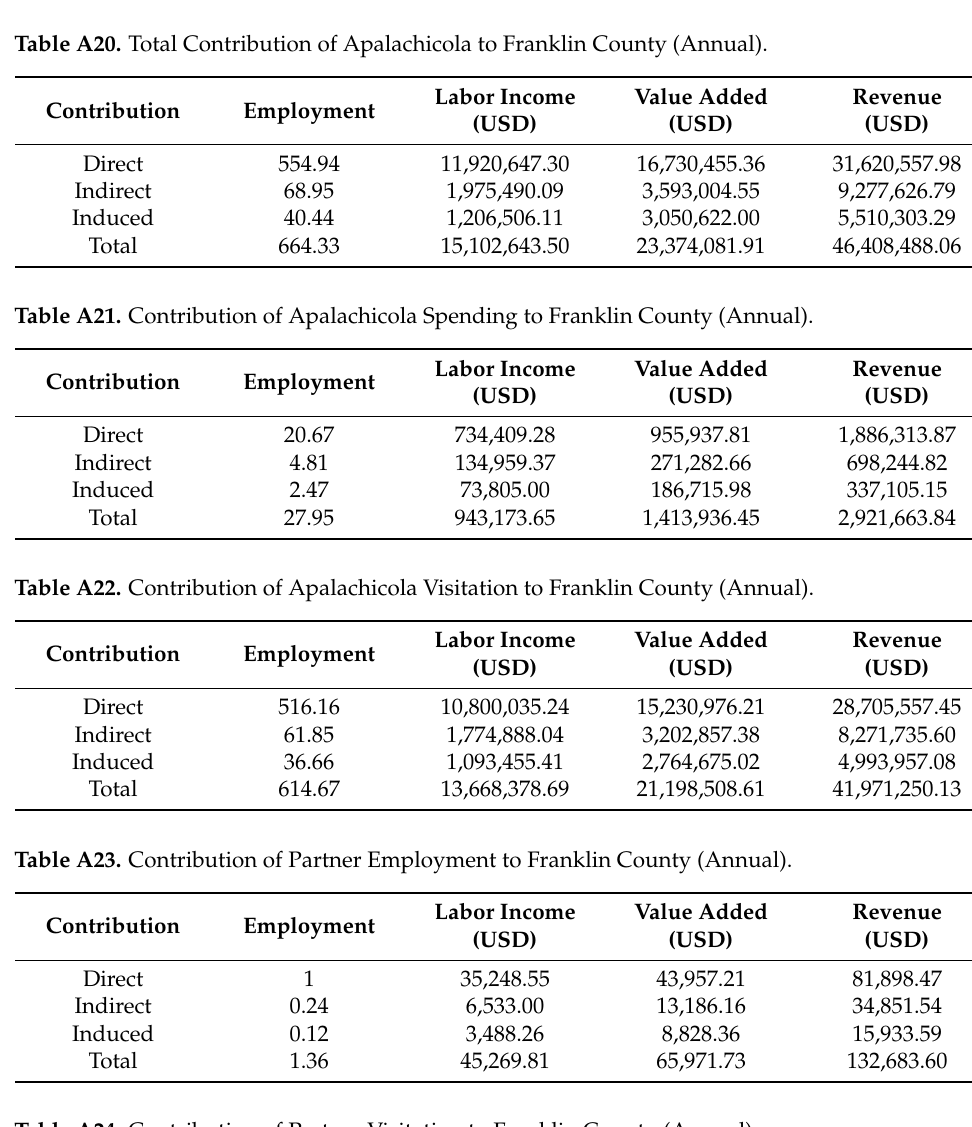
Table A24. Contribution of Partner Visitation to Franklin County